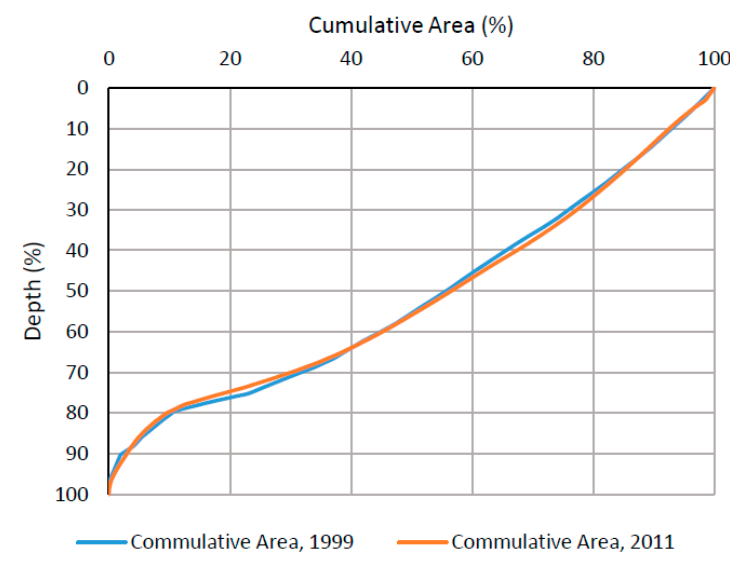
Figure 7. Lake Hawassa relative hypsographic curves.